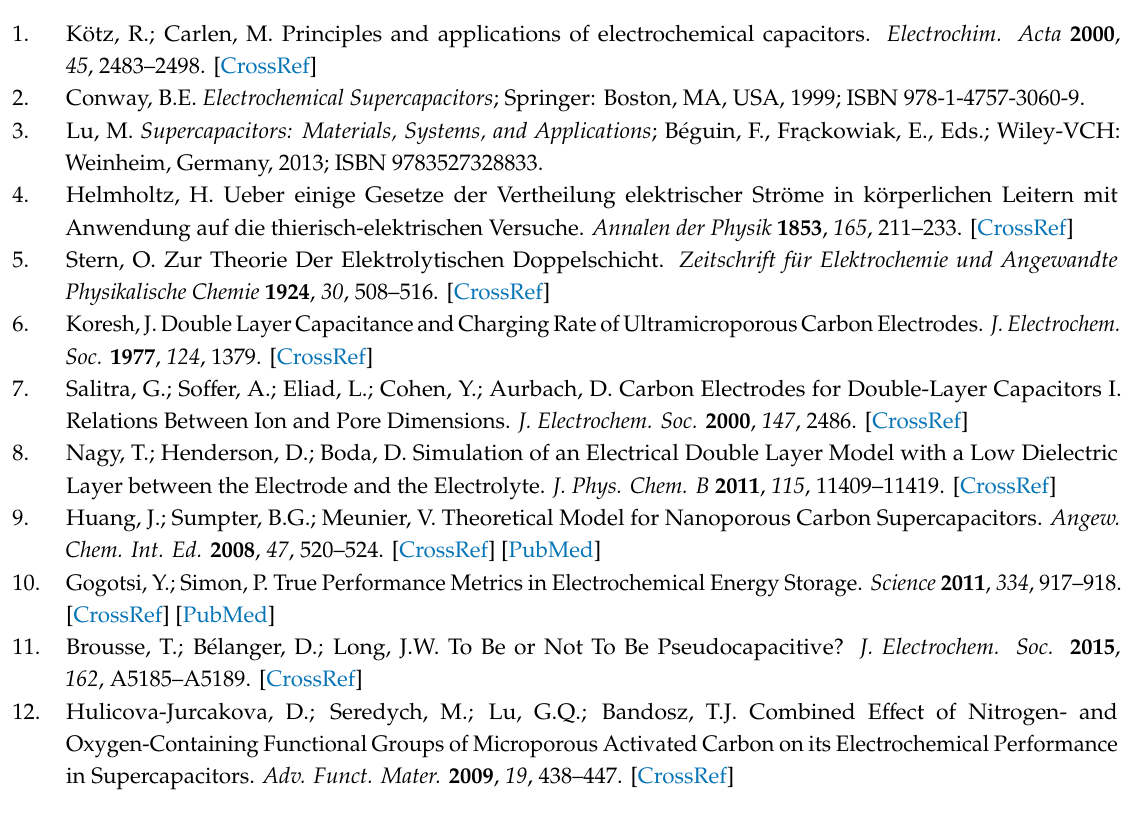
Figure S1: Comparative Nyquist plots for EDLC with starch as a binder in conductive glue for improved adhesion of electrode material to current collector (green solid line) and without adhesive conductive layer (red dotted line). Composition of electrodes 80 wt. % activated carbon (YP 80F) 10 wt. % carbon black (Super C65) and 10 wt. % starch. Figure S2: Cyclability of EDLC cells with starch binder in the voltage range from 0.0 V to 2.5 V at a current density of 0.5 A g − 1 and 1 mol L − 1 TEABF4 in ACN used as the electrolyte. Capacitance values and columbic e ffi ciency are represented as a solid green line and dotted orange line, respectively. Composition of electrodes 80 wt. % activated carbon (YP 80F) 10 wt. % carbon black (Super C65) and 10 wt. % starch. Figure S3: Electrode potential profiles and cell voltage of EDLC operating with aqueous electrolyte (1 mol L − 1 Na 2 SO 4 ) at current density 1.0 A g − 1 . Composition of electrodes 80 wt. % activated carbon (YP 80F) 10 wt. % carbon black (Super C65) and 10 wt. %